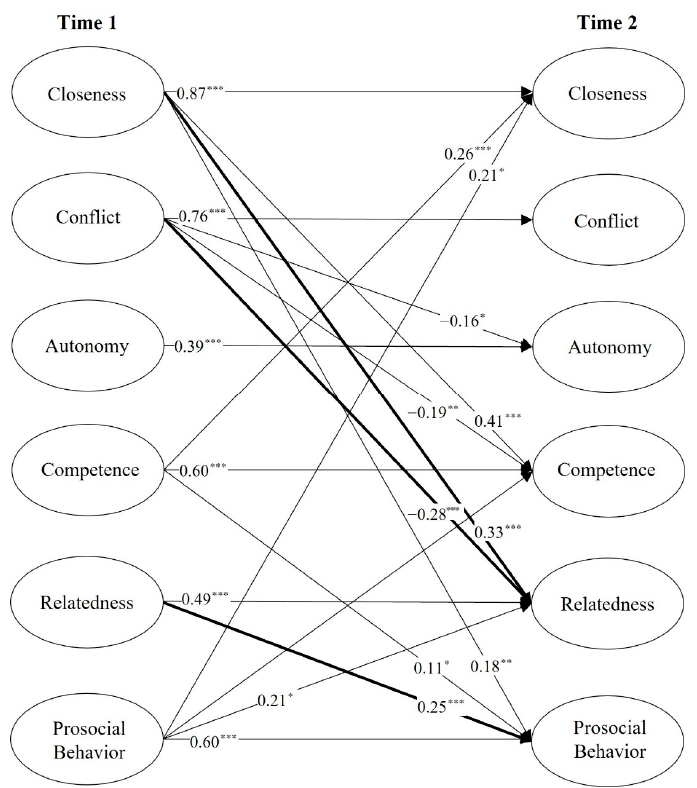
Figure 1. The final model. Note: Autonomy = autonomy need satisfaction; Competence = competence need satisfaction; Relatedness = relatedness need satisfaction; all the reported coefficients are standardized. Solid lines indicate significant paths. * p < 0.05, ** p < 0.01, *** p < 0.001.